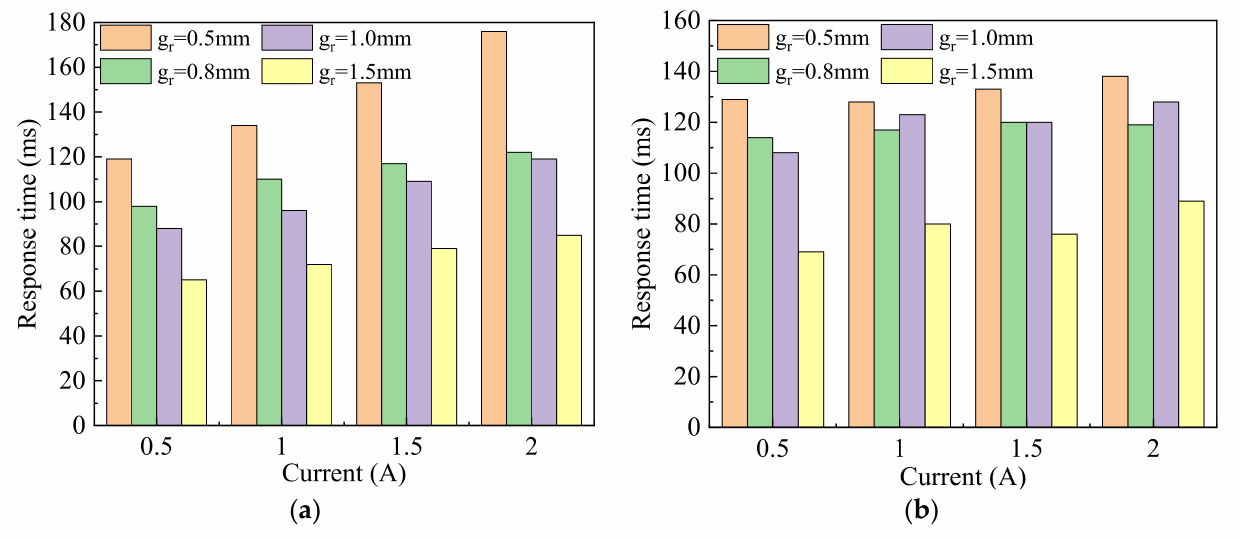
Figure 14. Comparison of response time of the MR valve under different radial damping gaps: ( a ) rising response time, ( b ) falling response